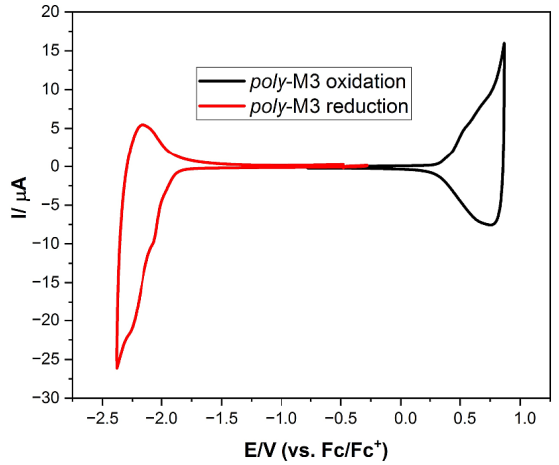
Figure 7. Voltammograms of poly - M3 (polymerization carried out potentiodynamically with upper potential as high as 0.82 V) with sweep rate ν = 100 mV/s, 0.1 M Bu 4 NPF 6 in CH 2 Cl 2 .